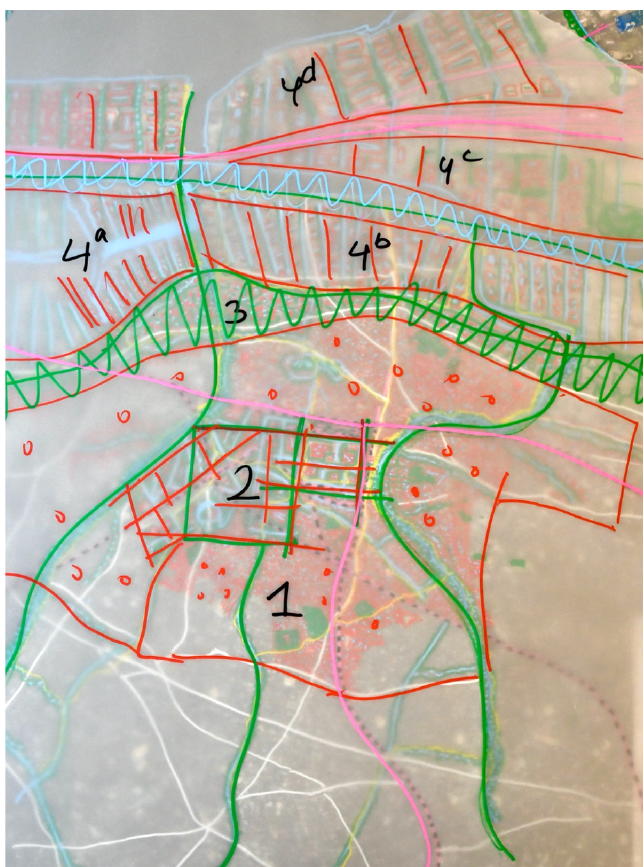
Figure 5. Four urban landscape typologies in